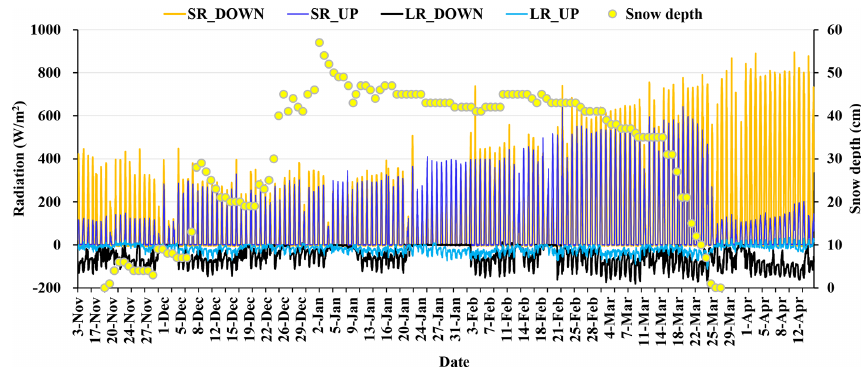
Figure 15. Minutely variation in four-component radiation and daily variation in snow depth at the Altay station from 3 November 2015 to 15 April